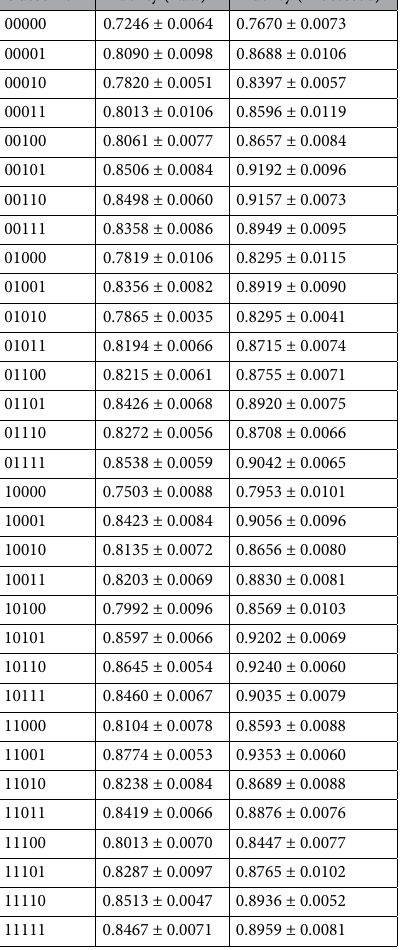
Table 1. Channel fidelities for the 32 random unitaries, corresponding to the 32 different measurement outcomes, generated with the exact 3-design on the ibmq_toronto quantum processor. ‘Raw’ shows the channel fidelities without quantum readout error mitigation. ‘Processed’ shows the channel fidelities with quantum readout error